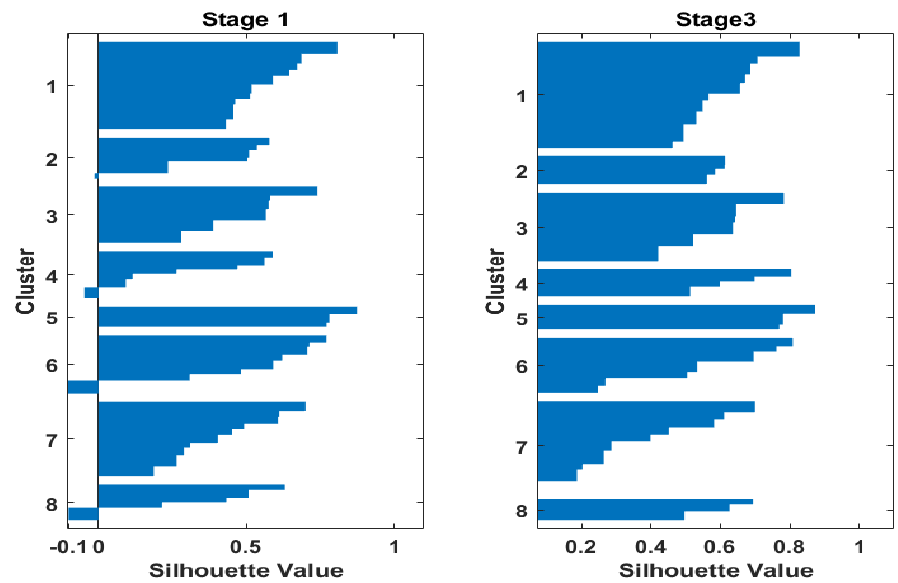
Figure 5. Silhouette plots 8 clusters for 25,307 audiograms stage 1 and 20,956 audiograms for stage 3.